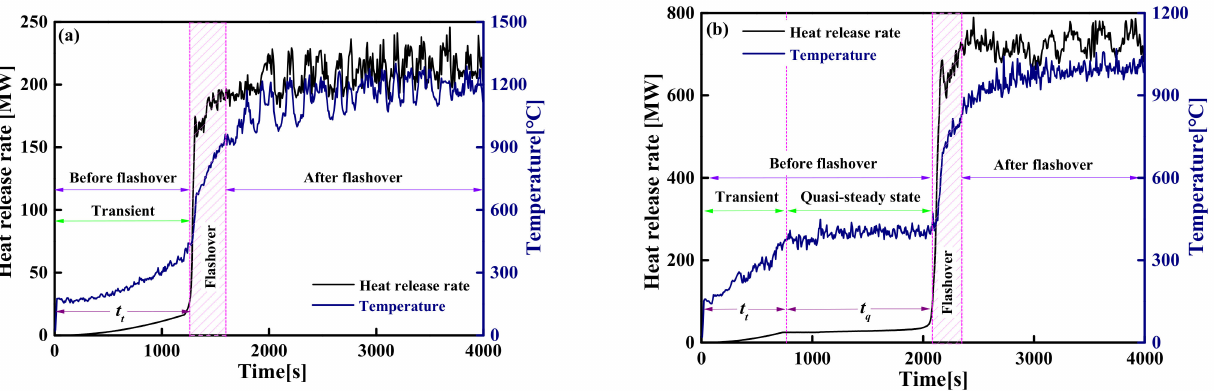
Figure 24. The evolution of the HRR and the temperature over time in flashover fire: ( a ) transient flashover fire; ( b ) transient quasi-steady-flashover fire.